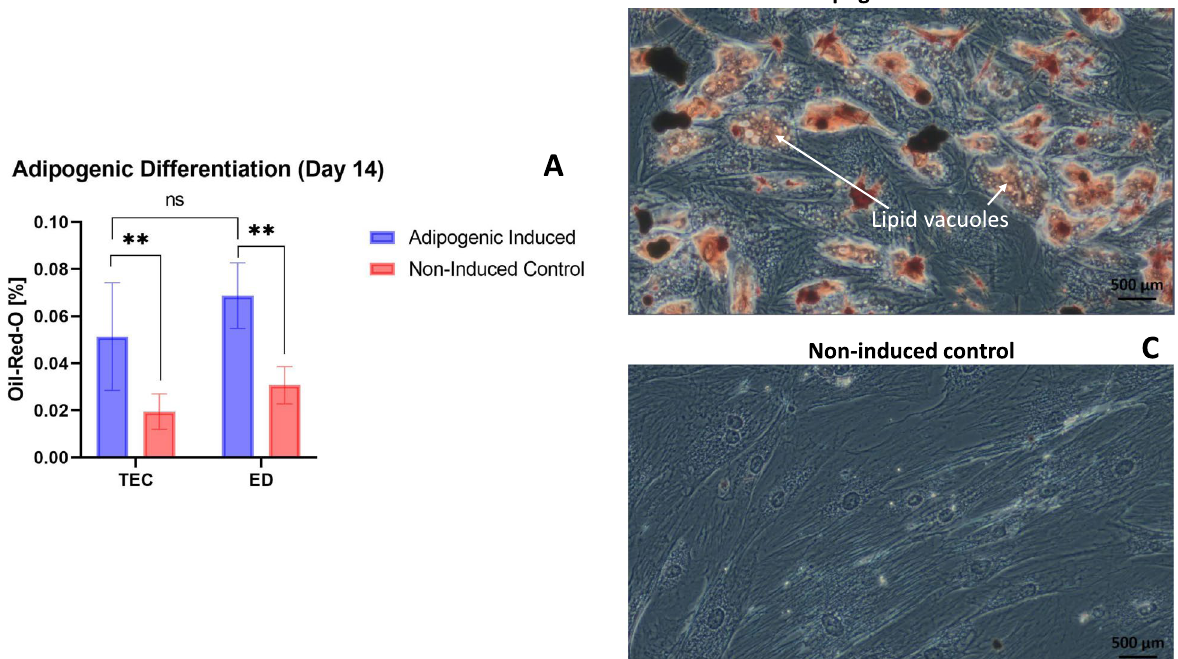
Fig. 3 Oil-Red-O staining of adipogenic induced and non-induced cells. ( A ) Box plot of Oil-Red-O concentration (%) of adipogenic induced and non-induced paired stem cells from cryopreserved microfragmented adipose tissue when isolated with tissue explant culture (TEC) and enzymatic digestion (ED), respectively. ns: non-significant, **: p < 0.01 when analyzed with paired t-tests. ( B) Phase contrast image (20x) of stem cells from cryopreserved microfragmented adipose tissue when isolated with TEC and stained with Oil-Red-O after 14 days of culture in adipogenic induction medium. Red color shows lipid vacuoles (arrows). ( C ) Phase contrast image (20x) of stem cells from cryopreserved microfragmented adipose tissue when isolated with TEC and stained with Oil-Red-O after 14 days of culture in normal expansion medium (negative control). Size bars show 500